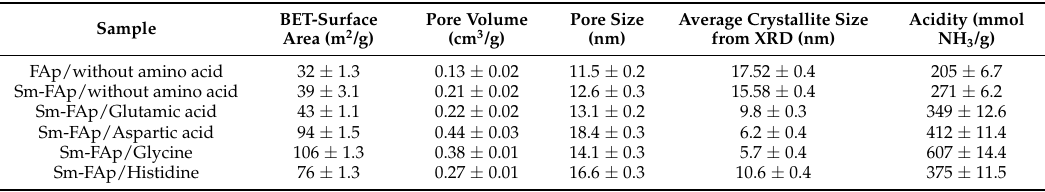
Figure 1. X-ray diffraction pattern of ( a ) FAp/without amino acid; ( b ) Sm-FAp/without amino acid; ( c ) Sm-FAp/Glutamic acid; ( d ) Sm-FAp/Aspartic acid; ( e ) Sm-FAp/Glycine; ( f ) Sm-FAp/Histidine. Table 1. BET-Surface area, pore properties and TPD data of catalysts.